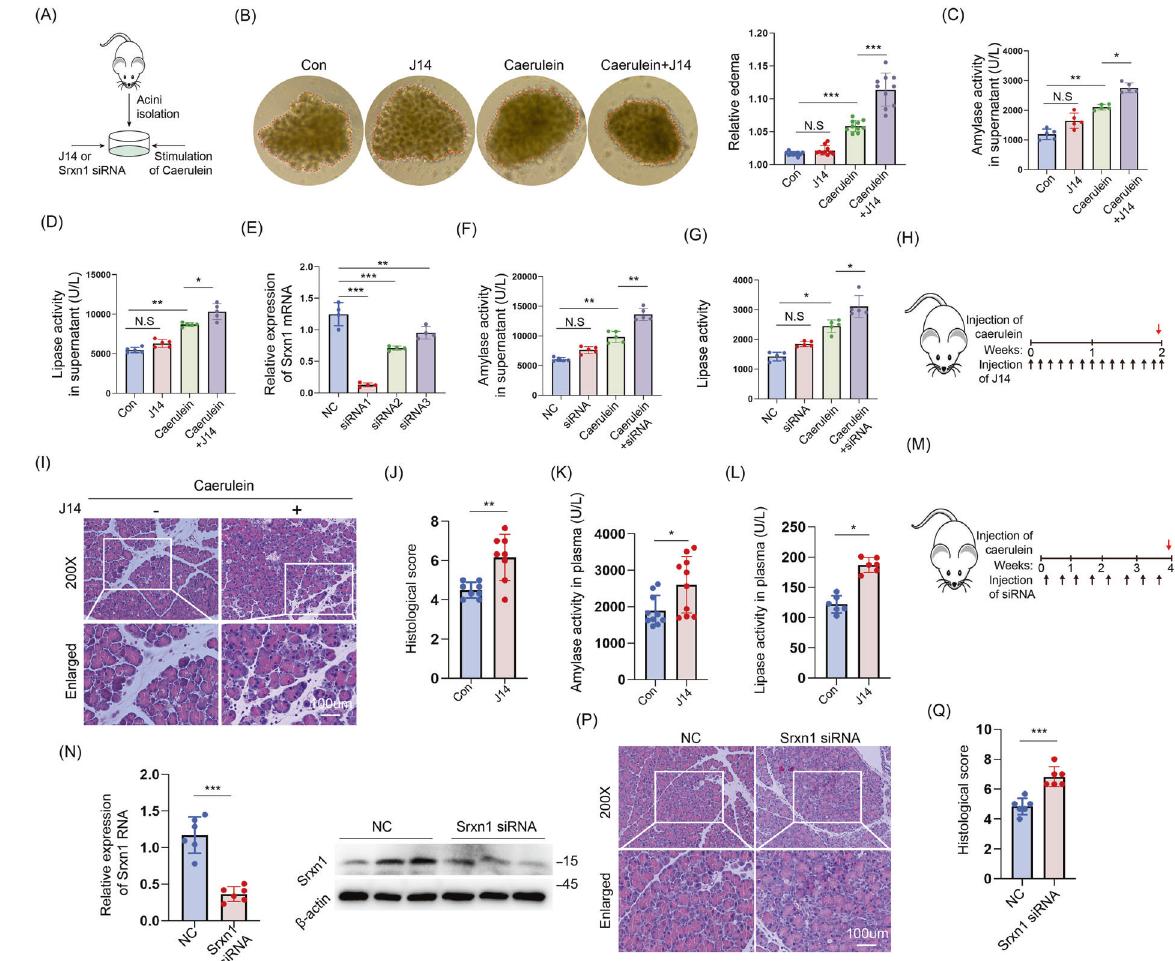
for 6 h signi fi cantly increased trypsin activity induced by cerulein (100 nM, 1 h) in acini. E siRNA1 exhibited the highest ef fi ciency and was used in the subsequent assays. F , G The trypsin activity of the siRNA + cerulein group was signi fi cantly higher than that of the cerulein group in acini. H J14 (in 10% DMAC + 10% Tween 80 + 80% saline) was intraperitoneally administered at a dose of 50 mg/kg body weight once a day for 2 weeks, and cerulein (50 µg/kg body weight) was administered by 8-hourly injection on the 13th day. I , J J14 strongly increased the histological score of cerulein-induced AP. K , L J14 signi fi cantly increased the trypsin activity of cerulein-induced AP. M Srxn1 siRNA was chemically modi fi ed and suitable for in vivo application. siRNA was administered by caudal vein injection at a dose of 20 nmol/mouse two times per week for a total of 4 weeks, and cerulein was injected 2 days after the last siRNA injection. N siRNA knockdown of the RNA and protein expression of Srxn1 in pancreatic tissue. P , Q Srxn1 siRNA increased the histology score of the pancreas induced by cerulein. Con control; NC negative control; N. S no signi fi cance, * p < 0.05, ** p < 0.01, *** p < 0.001; data represent fi ve or more experiments for in vitro assays and eight or more for in vivo